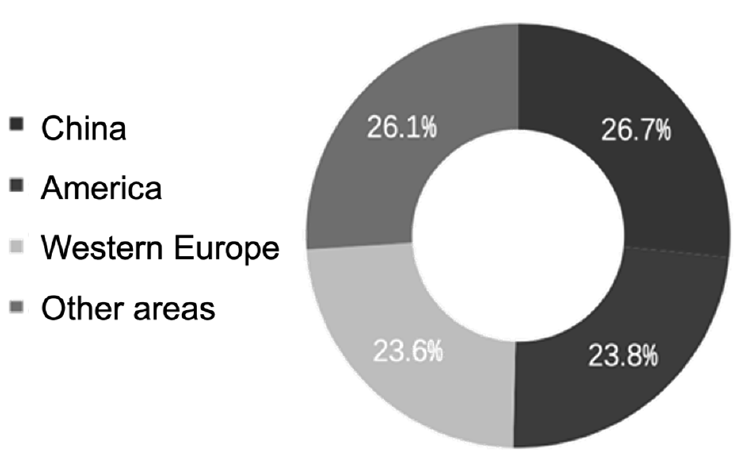
Figure 3. Forecast to 2024 for Global IoT spending.